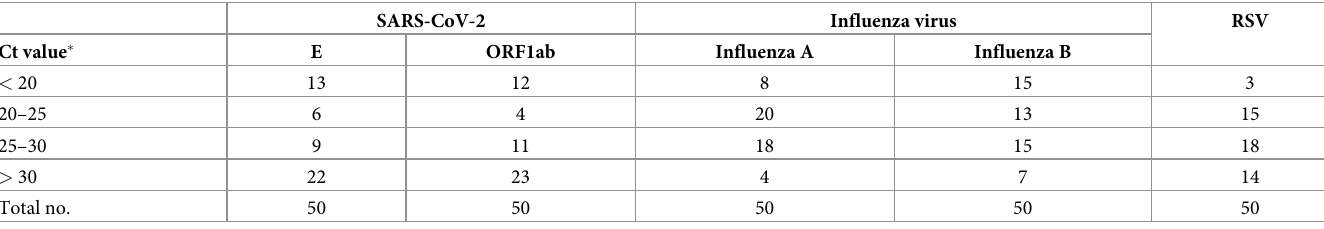
Table 1. Distribution of Ct values of positive specimens selected for this